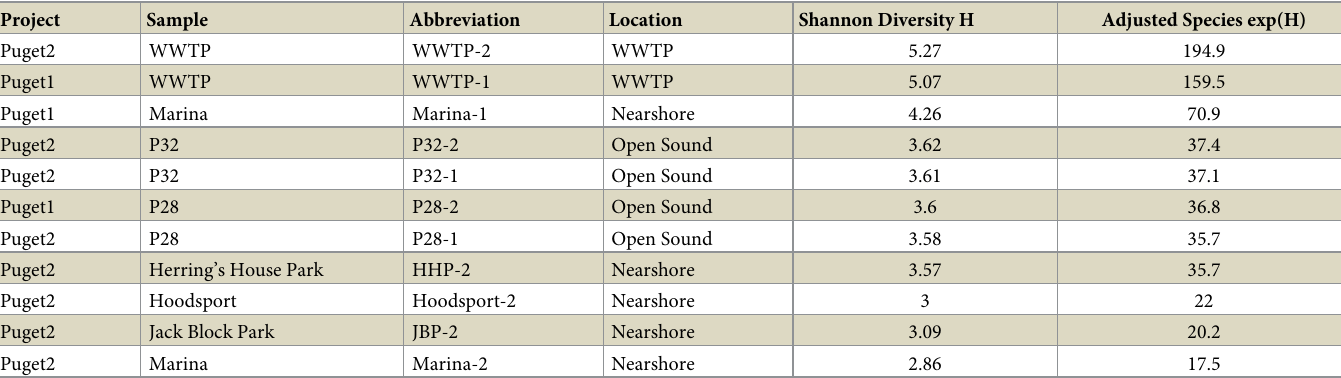
Table 2. Alpha-diversity for 11 metagenomic samples.